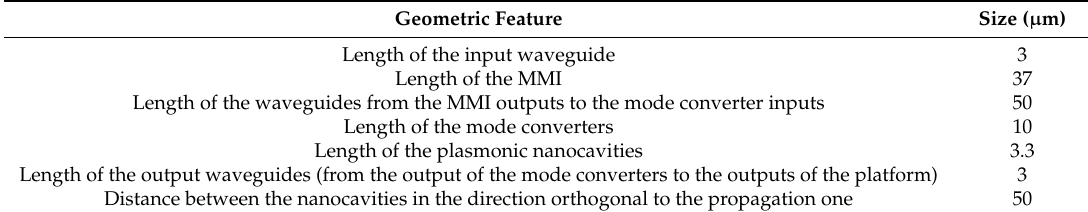
Table 2. Geometrical features of the biosensing